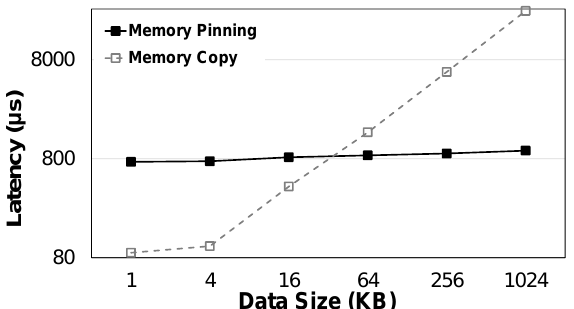
Figure 1. Time consumption of pin memory and memory